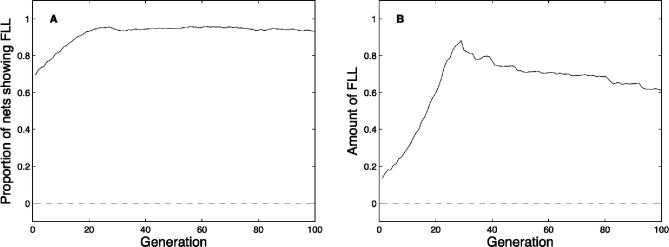
Prevalence and Amount of Free-Lunch LearningThe lines in each graph correspond to the conditions: FLL = solid line, NoFLL = dashed line. Performance error on A
1 was tested after learning A
2 in conditions FLL and NoFLL. Each plotted line is the mean of ten computer simulation runs (see Figure 4 for details).(A) Prevalence of FLL: the proportion of networks which showed improved performance on A
1 after learning A
2. In condition FLL, the prevalence of FLL was non-zero in the first generation, as expected (see text), and increased across subsequent generations. In condition NoFLL, the prevalence remained at zero, as expected.(B) Amount of FLL: in condition FLL, the amount of FLL increased dramatically over the first 30 generations. The absence of FLL in condition NoFLL is as expected (see text). The amount of FLL defined for this graph only is the difference in fitness error on A
1 before and after learning A
2, expressed as a proportion of the error on A
1 before learning A
2; or, equivalently, as [Epre(A
1) − Epost(A
1)]/Epre(A
1).